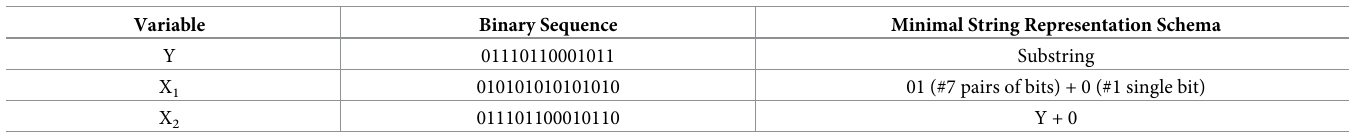
Table 5. Example of representation of strings X1 and X2 using substring Y.